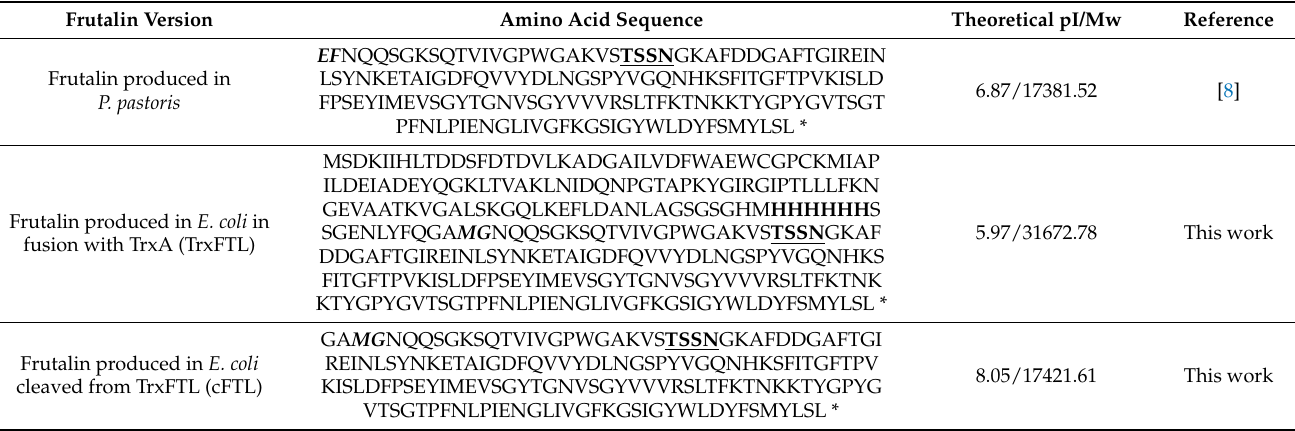
Figure 1. Putative molecular model of recombinant frutalin. The β chains are colored in yellow and the α chains in silver in tetrameric structure. The four amino acid linker TSSN, which binds α and β chains, is represented in red. The carbohydrate-binding site involves the N-terminus of the α chain and is formed by four key residues: Gly25, Tyr146, Trp147, and Asp149 [15]. Alterations in the spatial position of Trp residues upon frutalin binding to carbohydrates, principally in α chain, contribute to intrinsic fluorescence changes. The Trp residues are represented in green and magenta in α and β chains, respectively. Table 1. Amino acid sequences of frutalin produced in P. pastoris and E. coli , and calculated MW and pI.